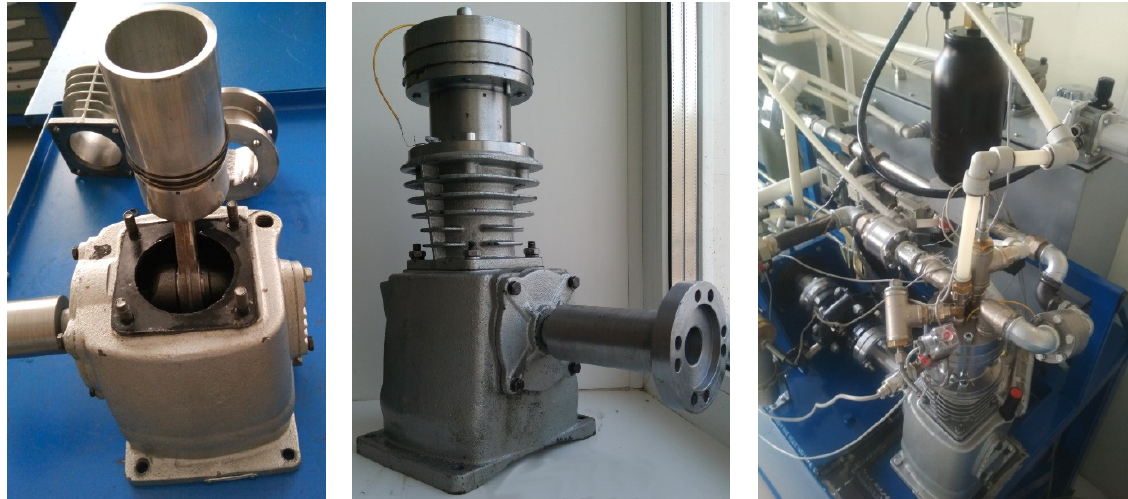
Figure 9. PHPM of crosshead-free and test bench in the installation area of crosshead-free PHPM.